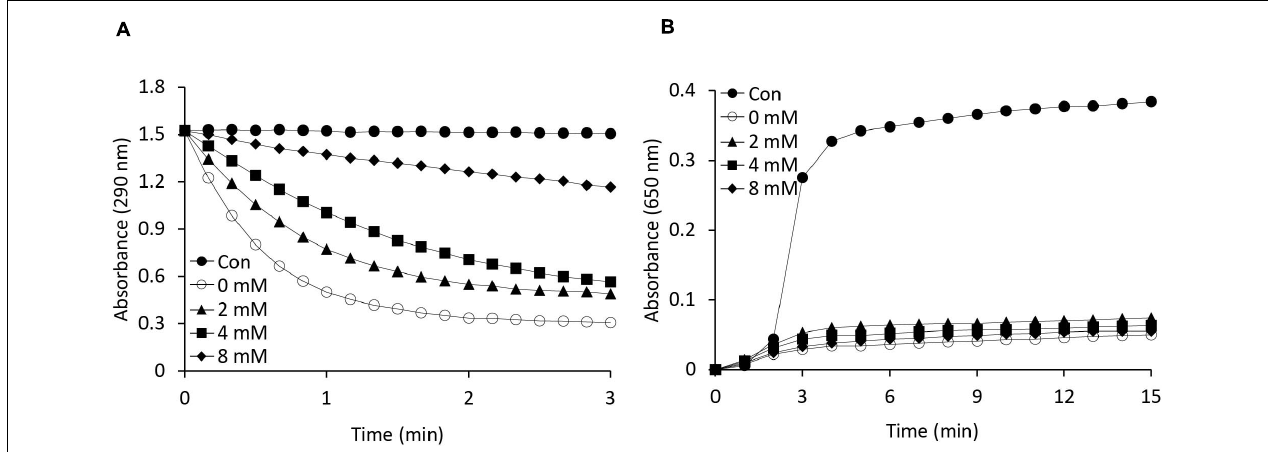
FIGURE 4 | Effects of a heme inhibitor (potassium cyanide) on the (A) peroxidase and (B) chaperone activities of AtAPX1 protein. To inhibit heme, we incubated AtAPX1 protein with